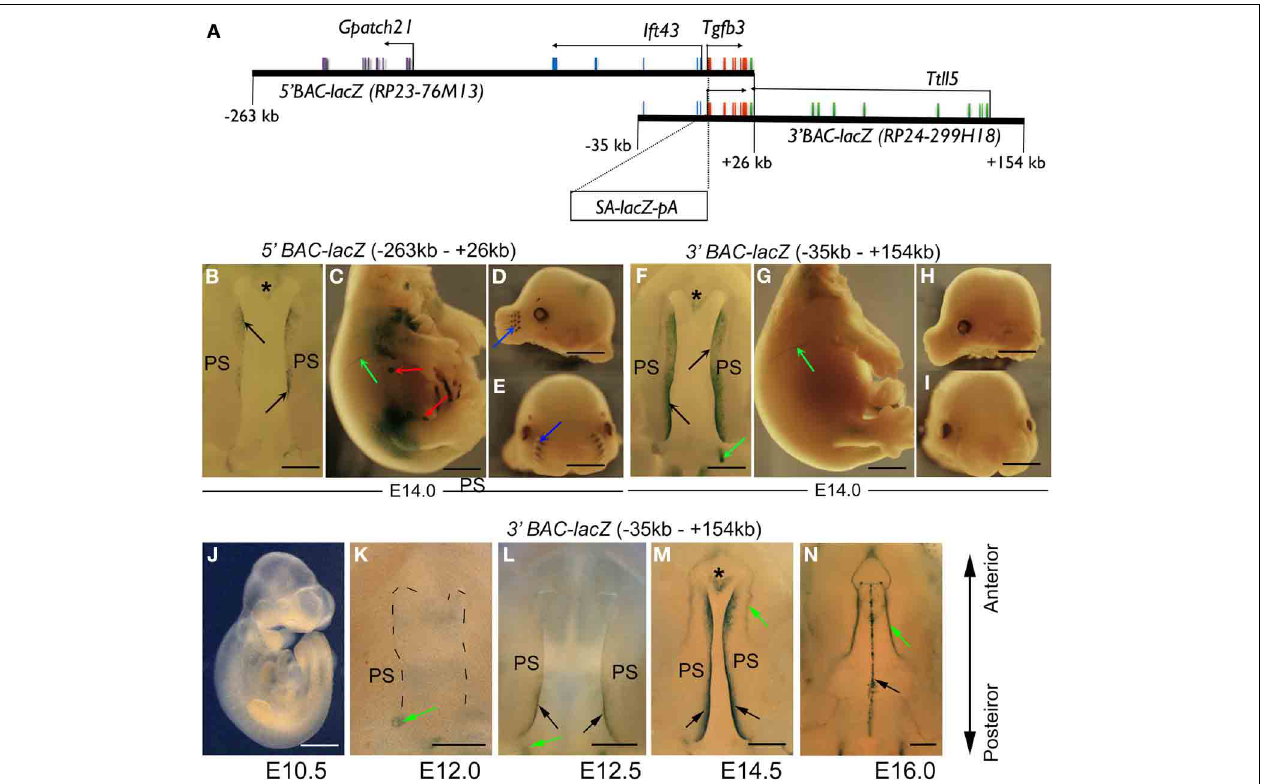
FIGURE 2 | Recombinant reporter BACs used to detect Tgfb3 regulatory regions. (A) Schematic representation of Tgfb3- containing lacZ BAC clones. Exons of the Tgfb3 gene are shown as red vertical bars and exons of Ttll5 , Ift43, and Gpatch21 genes are shown as green, blue and purple vertical bars, respectively. Horizontal black arrows show the direction of transcription of each gene. (B–E) 5 (cid:3) lacZ BAC transgenic embryos showing β -gal reporter activity (blue staining) in tips of palatal shelves ( B , black arrows), nasal septum ( B , asterisk, at anterior end of palate), blood vessels ( C , green arrow), mammary placodes ( C , red arrows) and in whisker follicles ( D,E , blue arrows). (F–I) , 3 (cid:3) lacZ BAC transgenic embryos showing β -gal reporter activity (blue